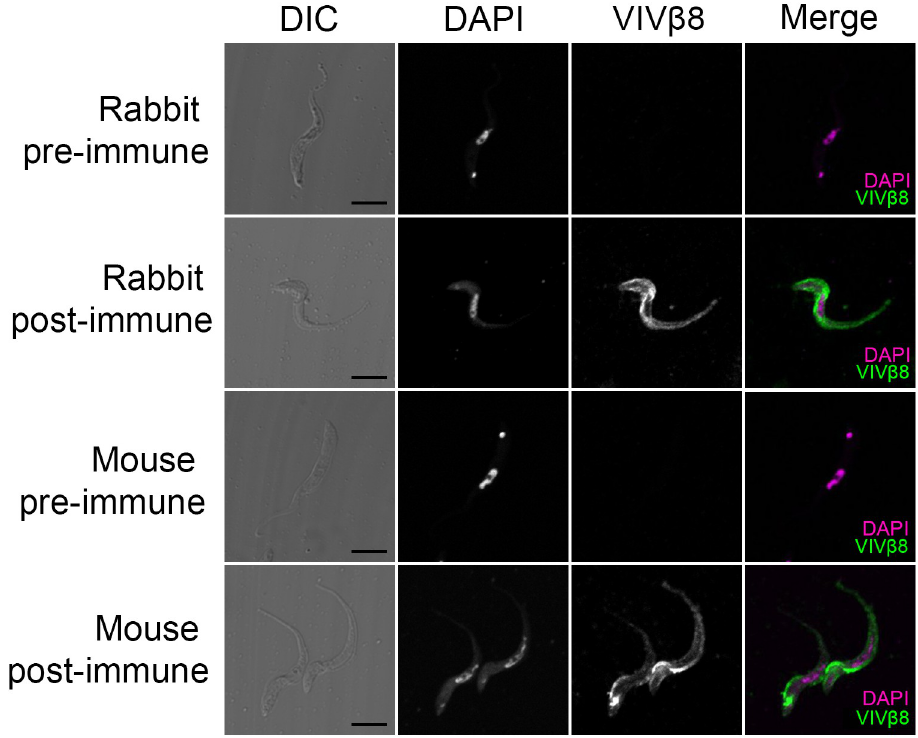
Fig 5. VIV β 8 immunostaining controls. Representative images of T . vivax bloodstream-form, formaldehyde-fixed cells either probed with pre-immune (pre) or post-immunization (post) antisera from either rabbit or mouse hosts vaccinated with VIV β 8. Only post-immunisation antisera display antibody binding. Scale bars; 5 μ m.